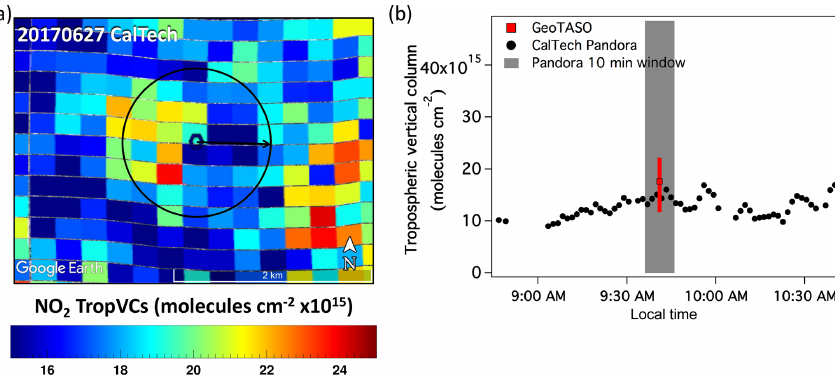
Figure 5. (a) Map of GeoTASO TropVCs on a linear color scale for the CalTech overflight on 27 June 2017 at 16:41UTC (09:41LDT) (yellow triangle in Fig. 3) with the 750m radius considered in the spatial binning of GeoTASO overlaid and an arrow depicting the Pandora viewing direction (solar azimuth angle) during the overpass time. The Pandora hexagon is colored by the NO 2 TropVC measured by Pandora during the overpass. (b) Time series showing Pandora data (black points) within approximately ± 1h of the GeoTASO overpass. The Pandora temporal window for the coincidence is shaded in gray, and the GeoTASO TropVC and 10th–90th percentiles from the overpass are shown in red. Base map created in ©Google Earth